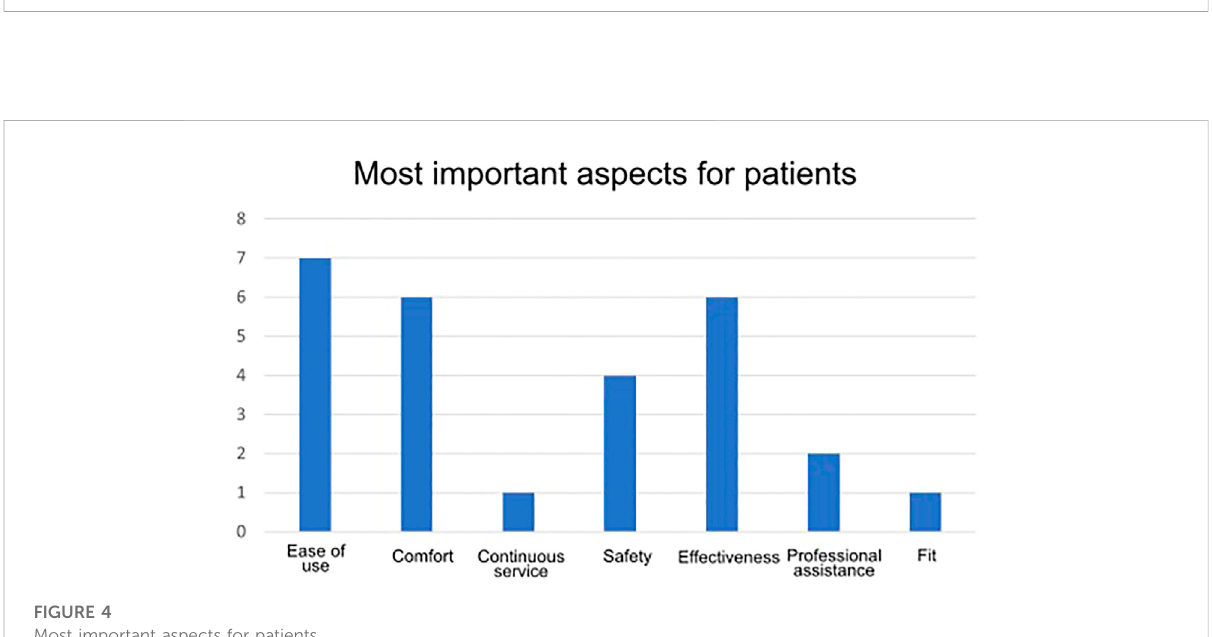
FIGURE 4 Most important aspects for